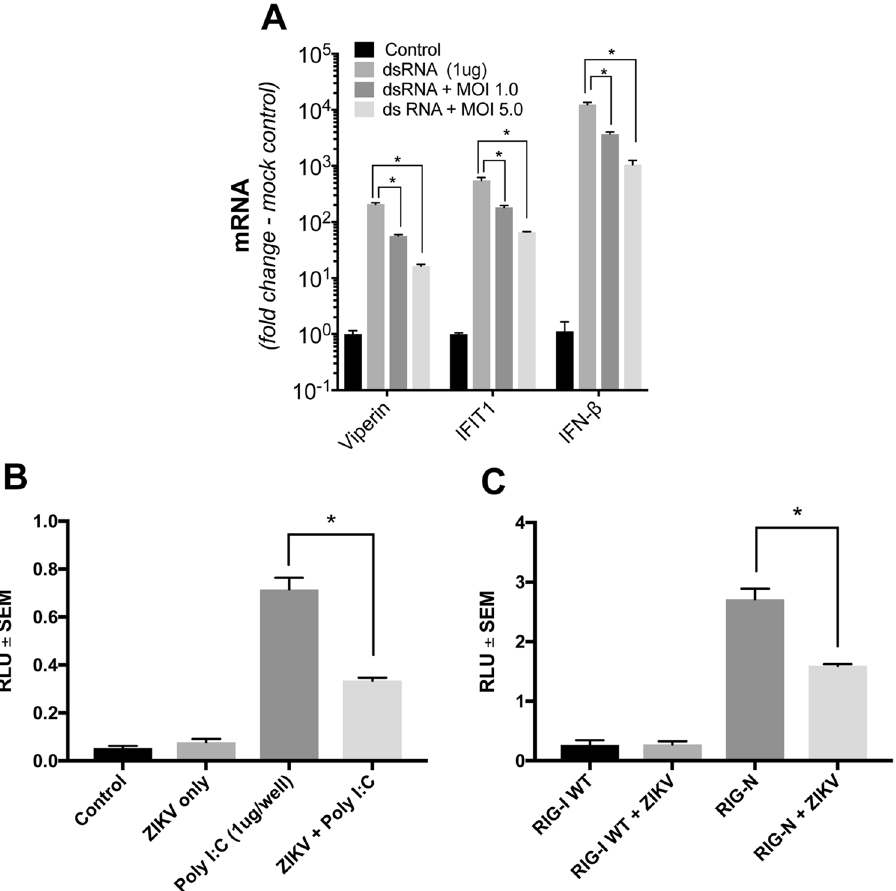
Figure 2. Poly I:C stimulated ISG expression and IFN- β promoter activity is attenuated in the presence of ZIKV infection. ( A ) Huh-7 cells were infected with ZIKV (MR766) at indicated MOIs and 16 h.p.i cells were transfected with polyI:C (1 μ g). 24 hr later total RNA was extracted and qRT-PCR was used to detect mRNA for IFN- β and the ISGs IFIT1 and viperin. Data are normalised to the RPLPO housekeeping gene and expressed as a fold-change relative to mock-infected control (data are means + SD, n = 3, * P = 0.0003, Students t-test). ( B ) Huh-7 cells were transfected with a luciferase reporter plasmid driven by the IFN- β promoter followed by infection with ZIKV (MR766, MOI 5). 16 h.p.i cells were transfected with polyI:C and 24 hr post transfection cell lysates were harvested for luciferase assay. Data are normalised to transfection with TK-Renilla plasmid and expressed as a relative light units compared to mock-infected control (data are means + SEM, n = 3, * P = 0.003, Students t-test). ( C ) Huh-7 cells were transfected with either a plasmid expressing WT RIG-I or a constitutively active RIG-I (RIG-N), together with a luciferase reporter plasmid driven by the IFN- β promoter followed by infection with ZIKV (MR766, MOI 5). 24 h.p.i cell lysates were harvested for luciferase assay. Data are normalised to transfection with TK-Renilla plasmid and expressed as a relative light units compared to uninfected cells (data are means + SEM, n = 3, * P = 0.002, Students